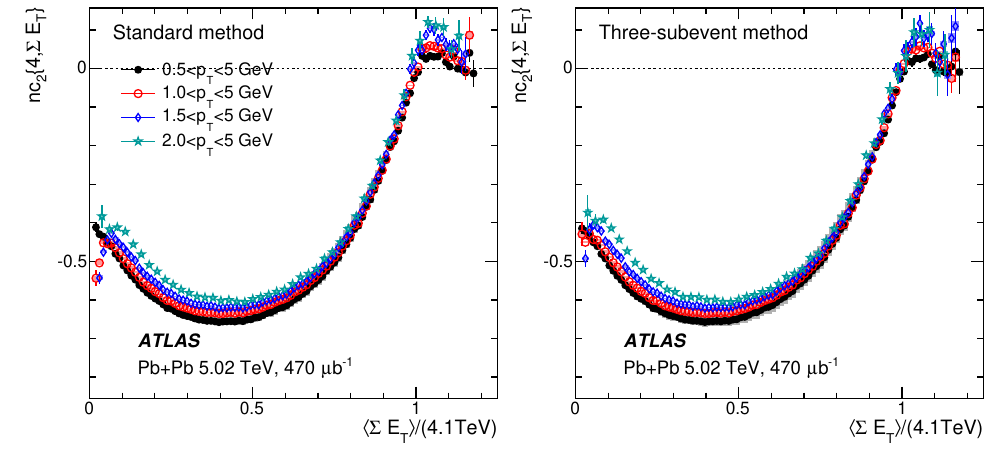
Figure 25 . The nc 2 f 4 g values calculated for charged particles in several p T ranges with the standard cumulant method (left) and three-subevent method (right). The error bars and shaded boxes represent the statistical and systematic uncertainties, respectively. Zero is indicated by a dotted